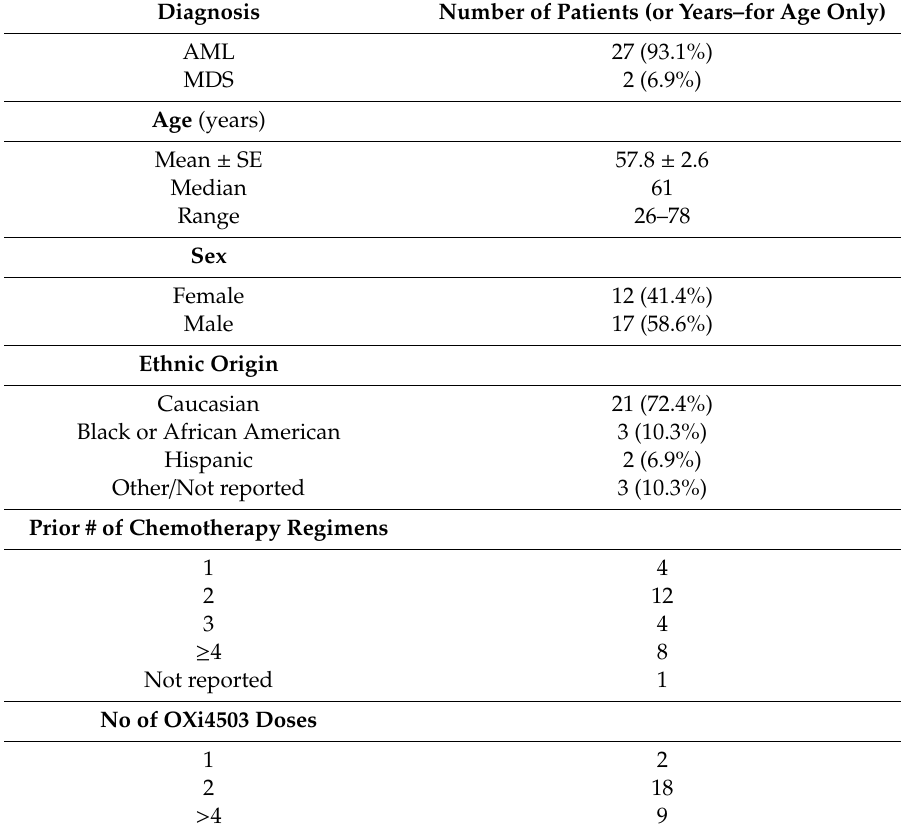
Table 1. Patient Characteristics and Demographic Features for